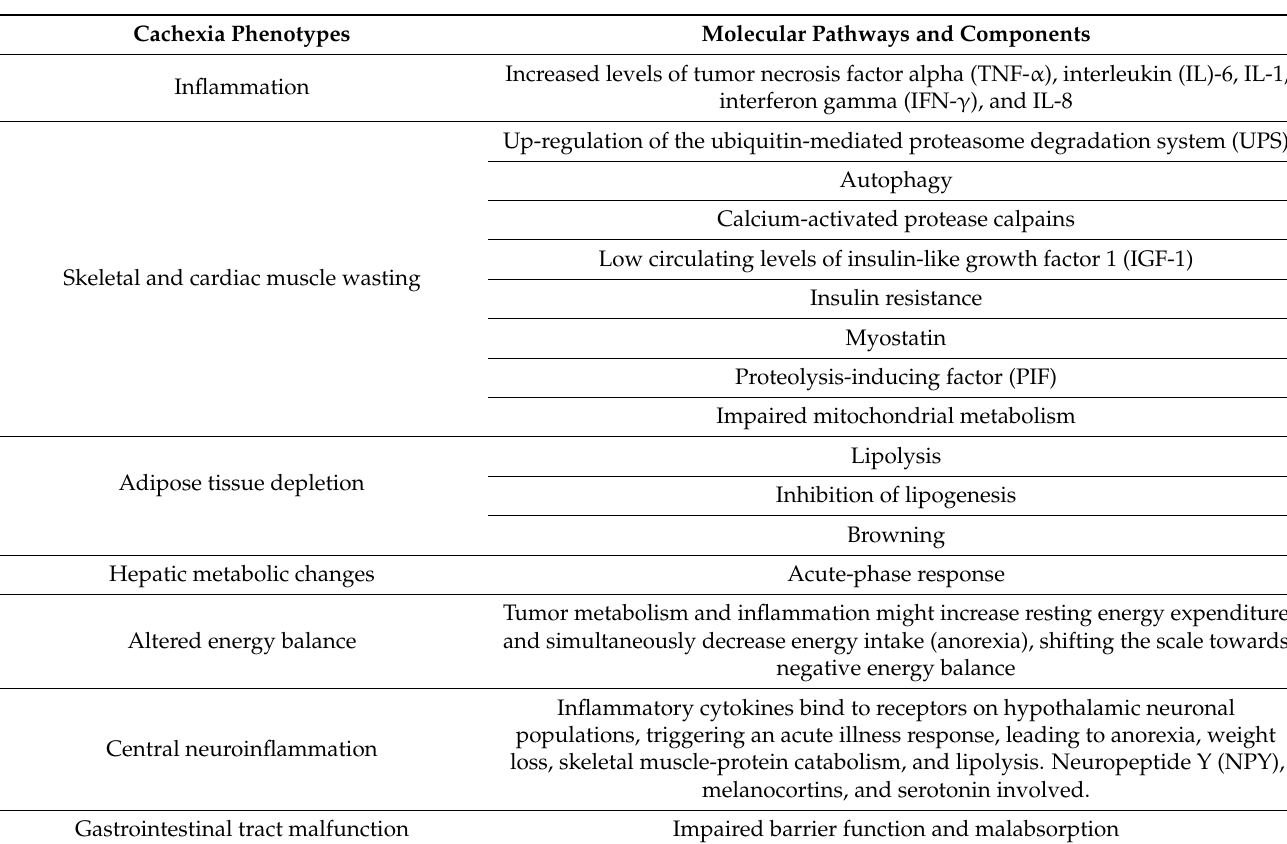
Table 1. Cachexia’s phenotypes and respective molecular pathways and